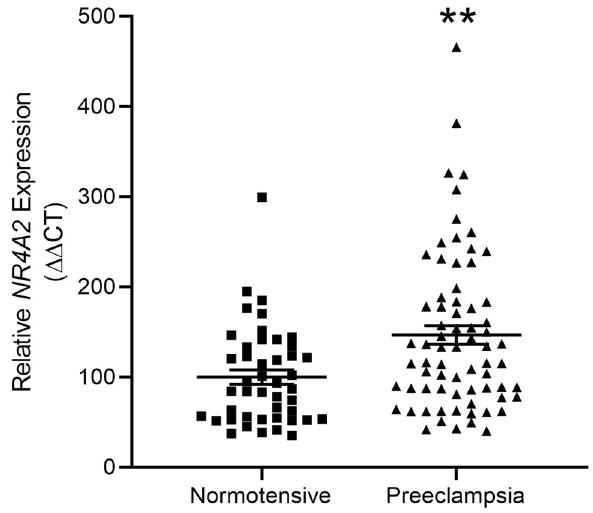
Figure 1. Circulating NR4A2 mRNA in cases of normotensive preterm fetal growth restriction and preeclampsia with growth restriction (< 34 weeks gestation). RNA levels were assessed by qPCR. Cases with preeclampsia and growth restriction had significantly higher circulating NR4A2 mRNA compared to normotensive cases of growth restriction. Data presented as relative change from normotensive